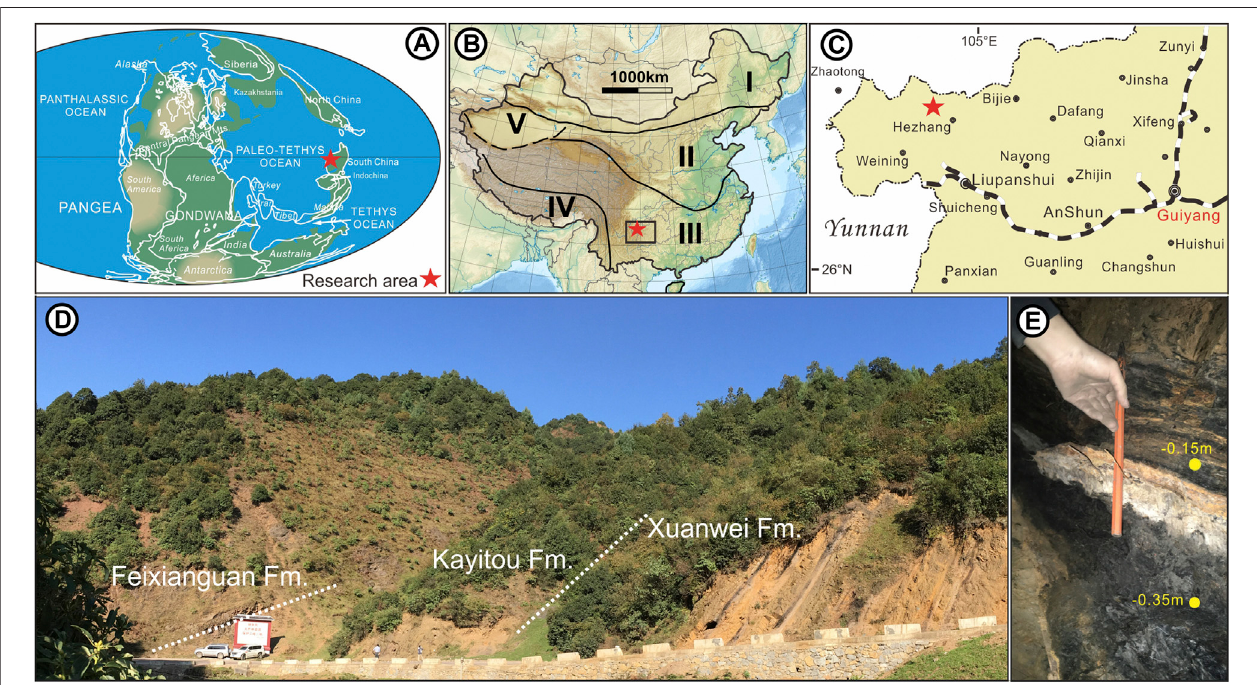
FIGURE 1 | The Lopingian (late Permian) maps, phytogeoprovinces and the location of the studied section. (A) Palaeogeographic map of the Lopingian showing thestudyarea(asterisk)(Modi fi edfromScotese,2001). (B) Mapshowingthelocation(asterisk)ofthestudyareaand latePermianphytogeoprovincesinChina(Modi fi ed from Shen, 1995). (C) Map showing the location of the Lengqinggou section (asterisk). (D) Outcrop photo of the Lengqinggou section. (E) Photo of the uppermost coal withanashbedatthetoppartoftheXuanweiFormation,labeledwithsamplepositions.I-AngaraprovinceinJunggar – HingganRegion;II-Cathaysisa – Euramerica – Angara mixed province; III- Cathaysia province; IV- Gondwana province; V-Angara province in Tarim Plate.